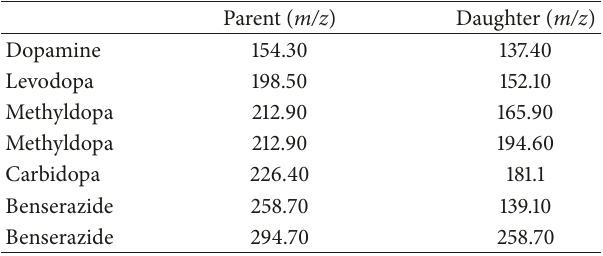
Table 1: Multiple reaction monitoring